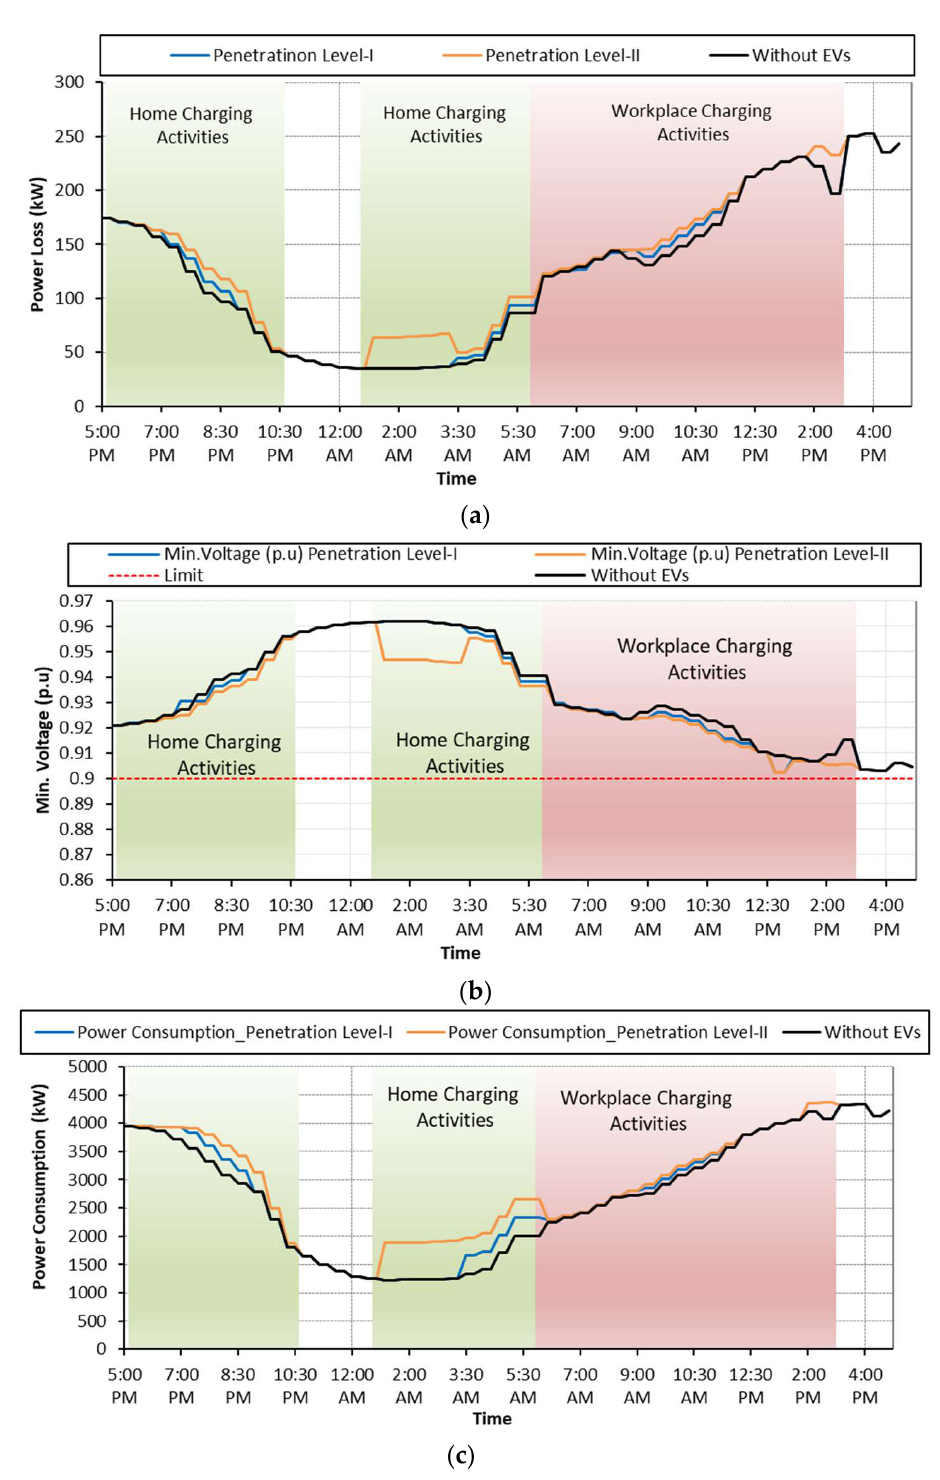
Figure 14. Case D: ( a ) Network power loss; ( b ) voltage deviation; ( c ) network power consumption .